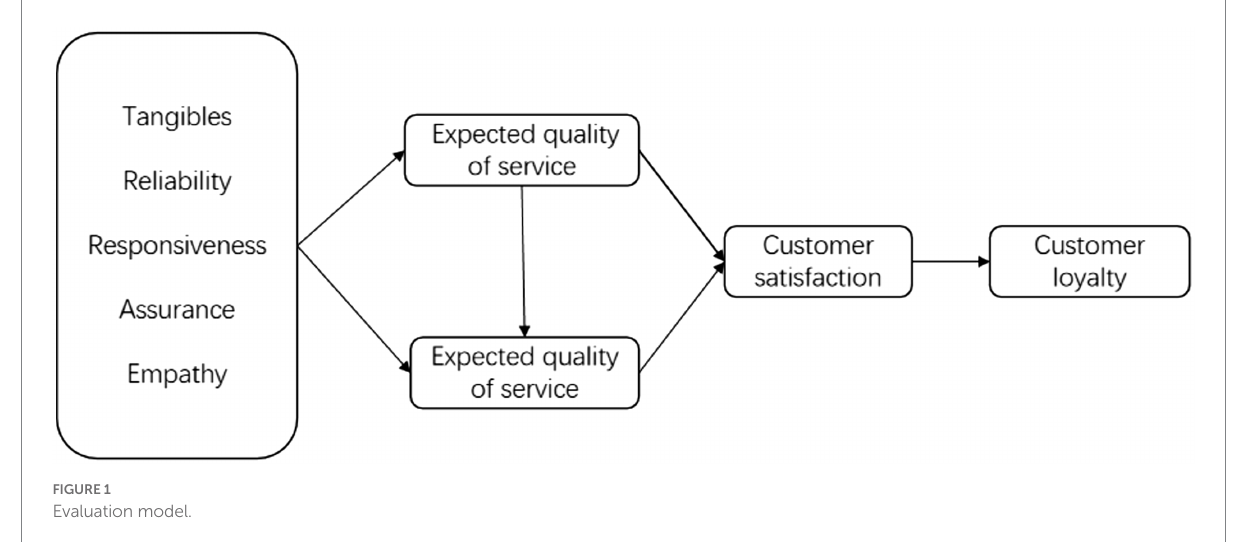
FIGURE 1 Evaluation